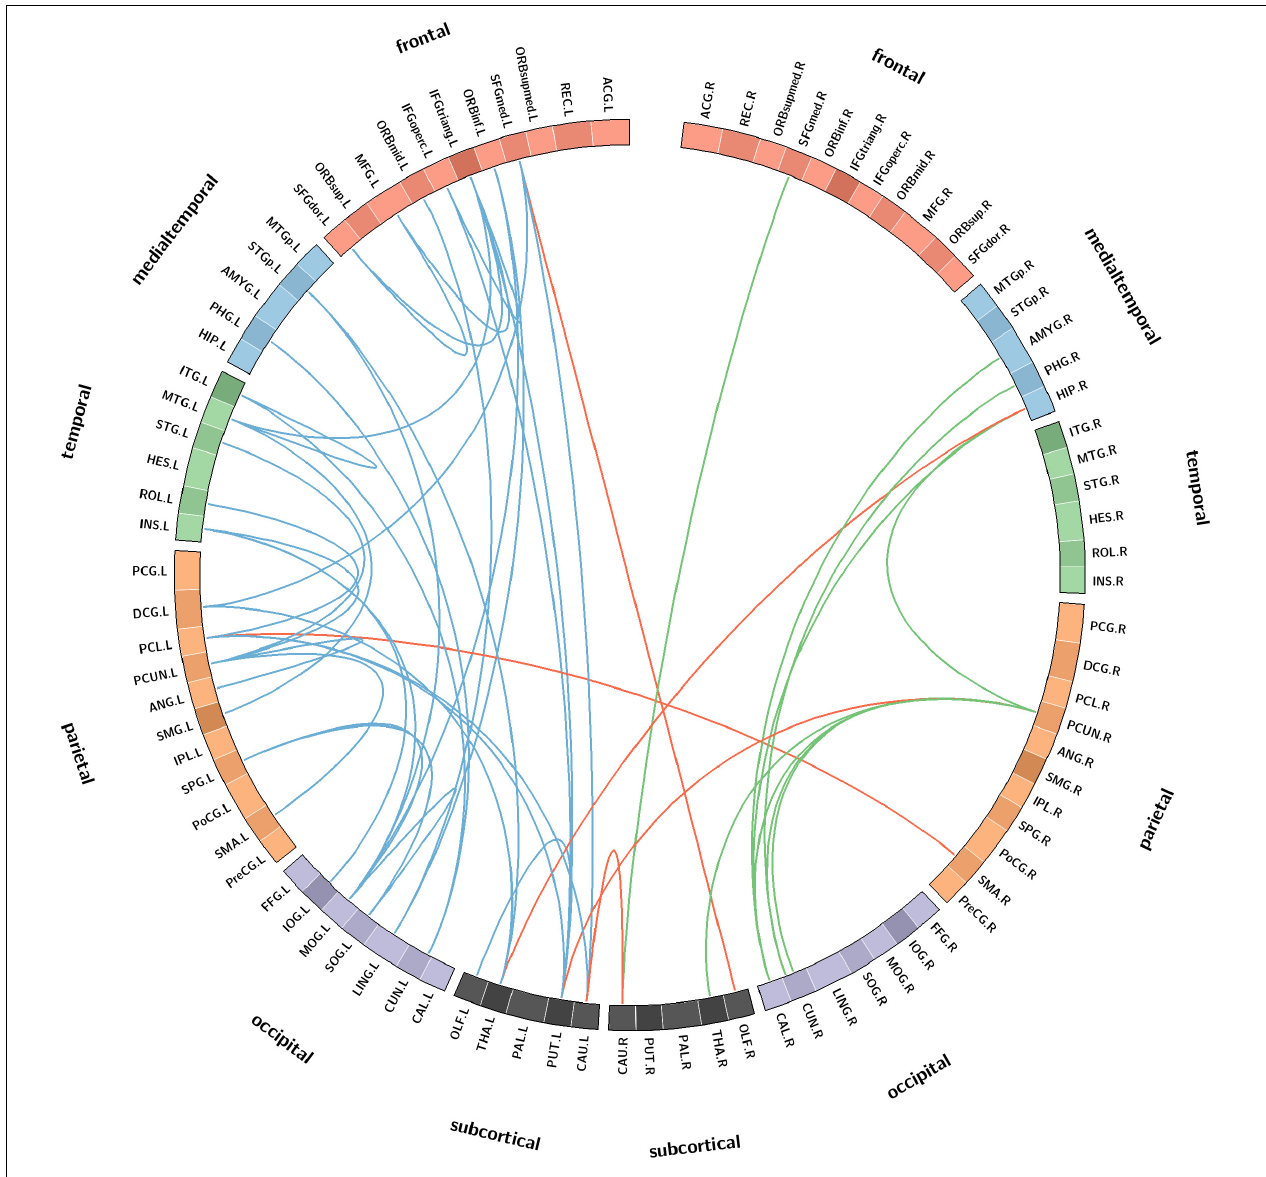
FIGURE 4 | Connectograms show the decreased structural connections in SIVCIND patients compared to NCs (NBS corrected, p < 0.01). Links are colored by connection type as follows: left intrahemispheric (blue), interhemispheric (red) and right intrahemispheric (green). ROIs were grouped according to Salvador (Salvador et al., 2005) (i.e., frontal, temporal, parietal, medial temporal, occipital, and